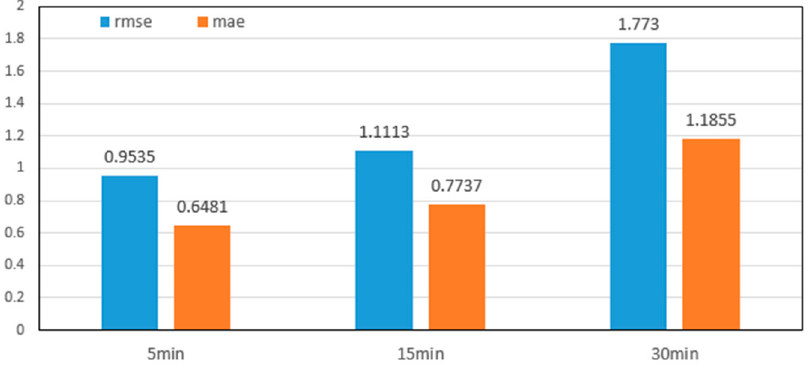
Figure 8. Impacts of the length of the time slot on the prediction performance.